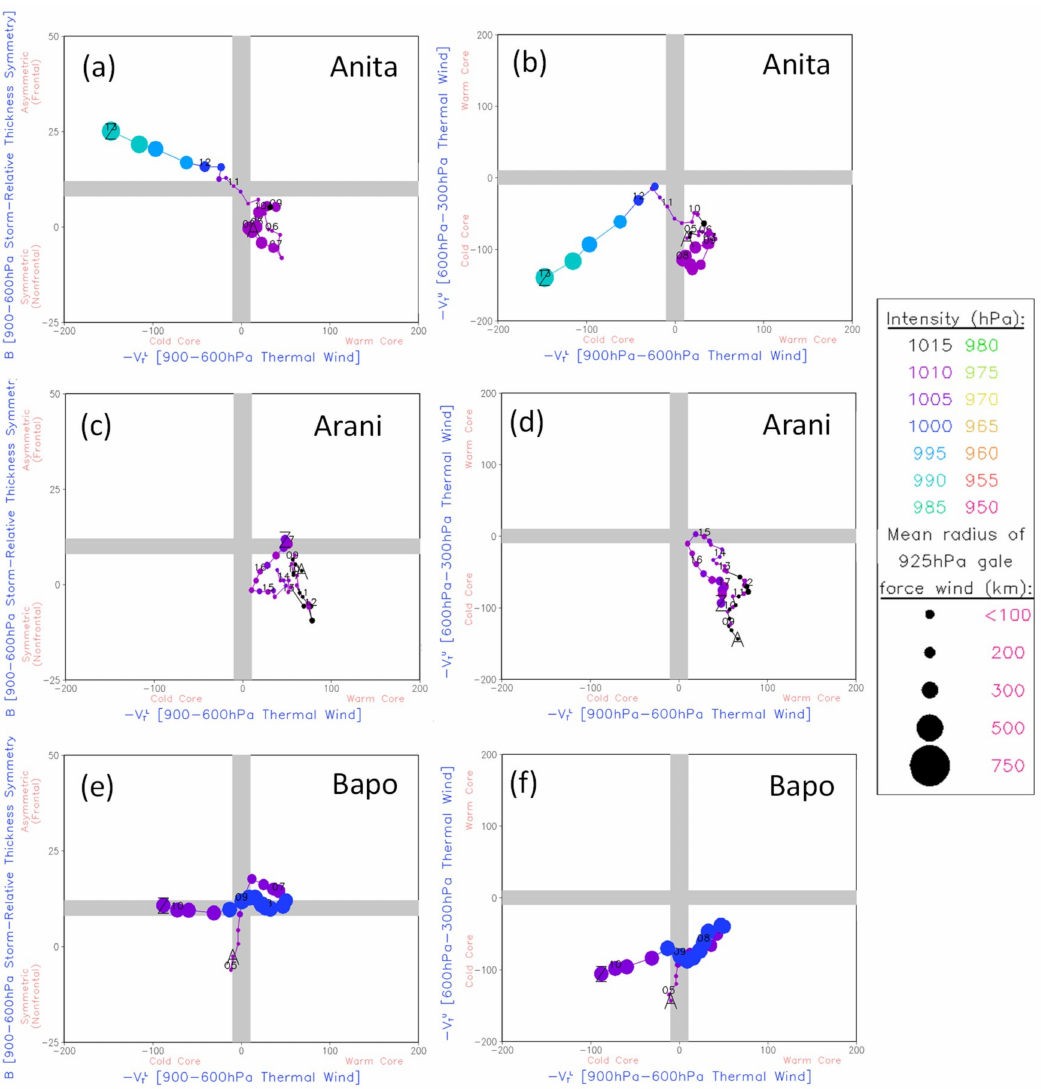
Figure 2. Cyclone Phase Space (CPS) of Anita, Arani, and Bapo. ( a , c , e ): The left column presents the parameters B versus –V TL ; ( b , d , f ): the right column presents the parameters –V TL versus –V TU . A and Z indicate, respectively, the first and the last time of the cyclone lifecycle. The circle size indicates the mean radius of the wind gale force at 925 hPa (17 m · s − 1 ) and the colors are the sea-level pressure values (see scale in the right of figure). Positions at 0000 Z are labeled with the